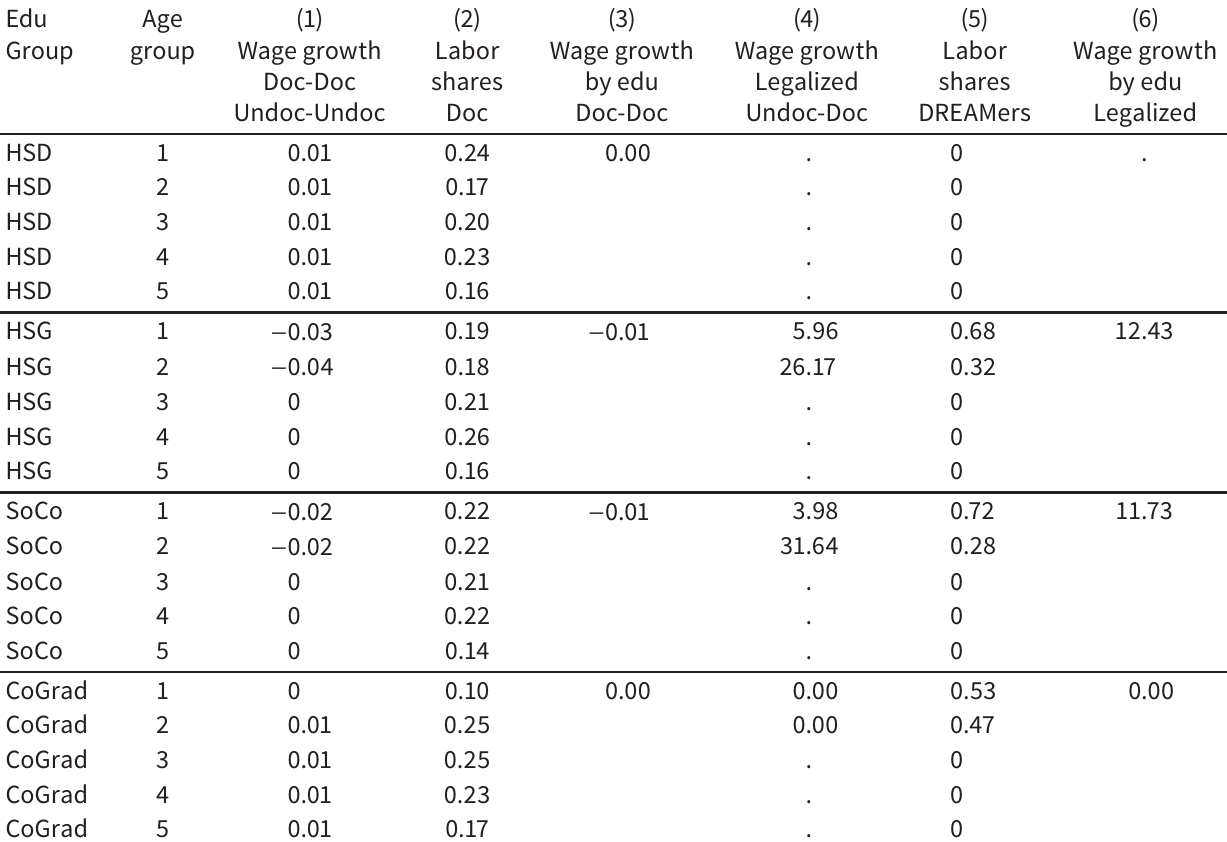
Wage Effects of DACA. Percent Changes Relative to